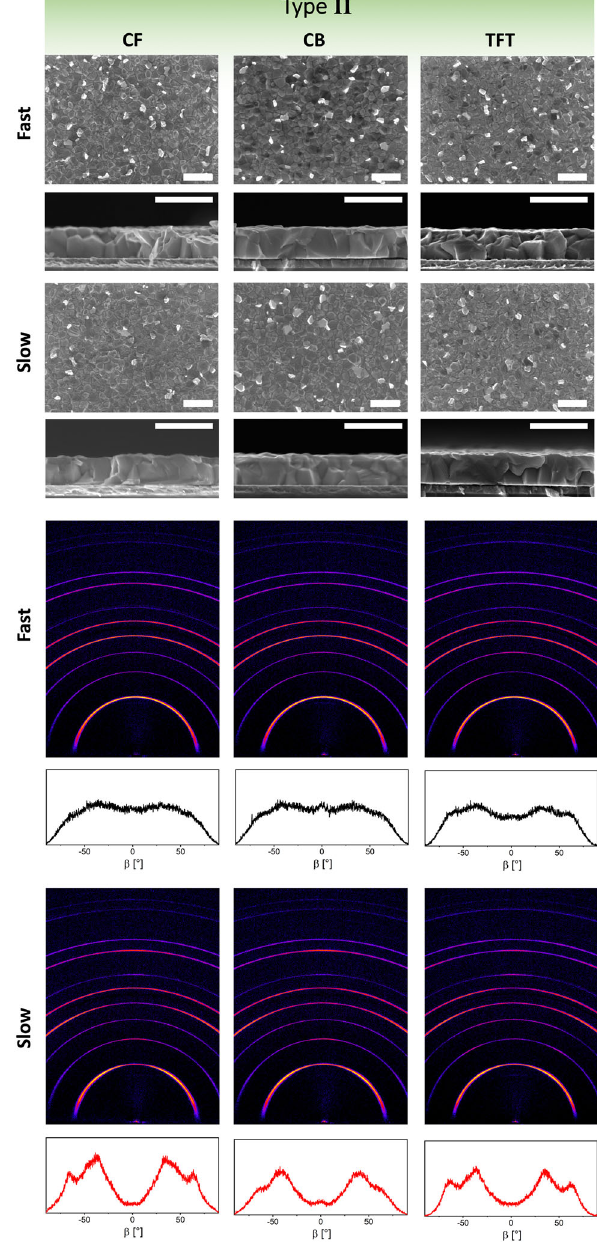
Fig. 3 Microstructural and structural characterization of perovskite fi lms deposited by type I antisolvents. Top: surface and cross-sectional scanning electron microscopy images of perovskite fi lms formed from type I antisolvents (EtOH, IPA, and BuOH). Scale bar is 1 μ m. Bottom: 2D XRD maps and corresponding ß integration of the (100) re fl ection to visualize changes in grain orientation. The arrow highlights the re fl ection associated with PbI 2 .